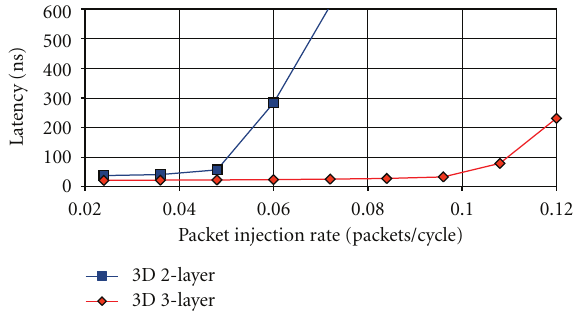
Figure 27: Latency for 2-layer and 3-layer implementations of ami33 .